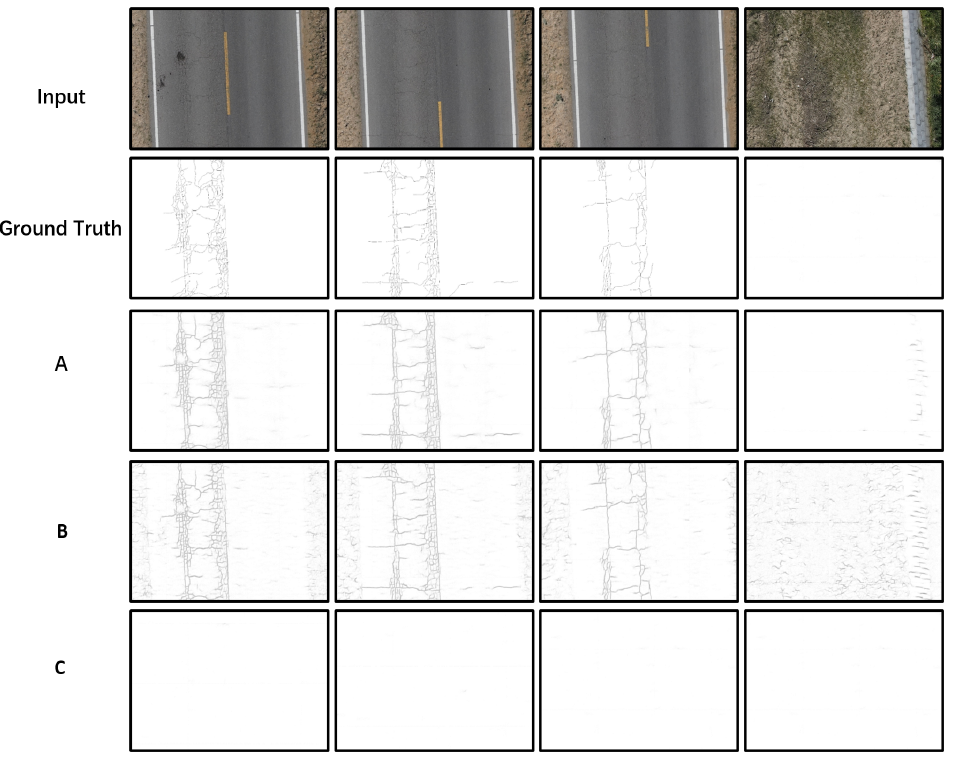
Figure 7. Results for the crack detection of three different methods on UCrack. ( A ) Group A named in Section 4.3.2, ( B ) Group B, ( C ) Group C.